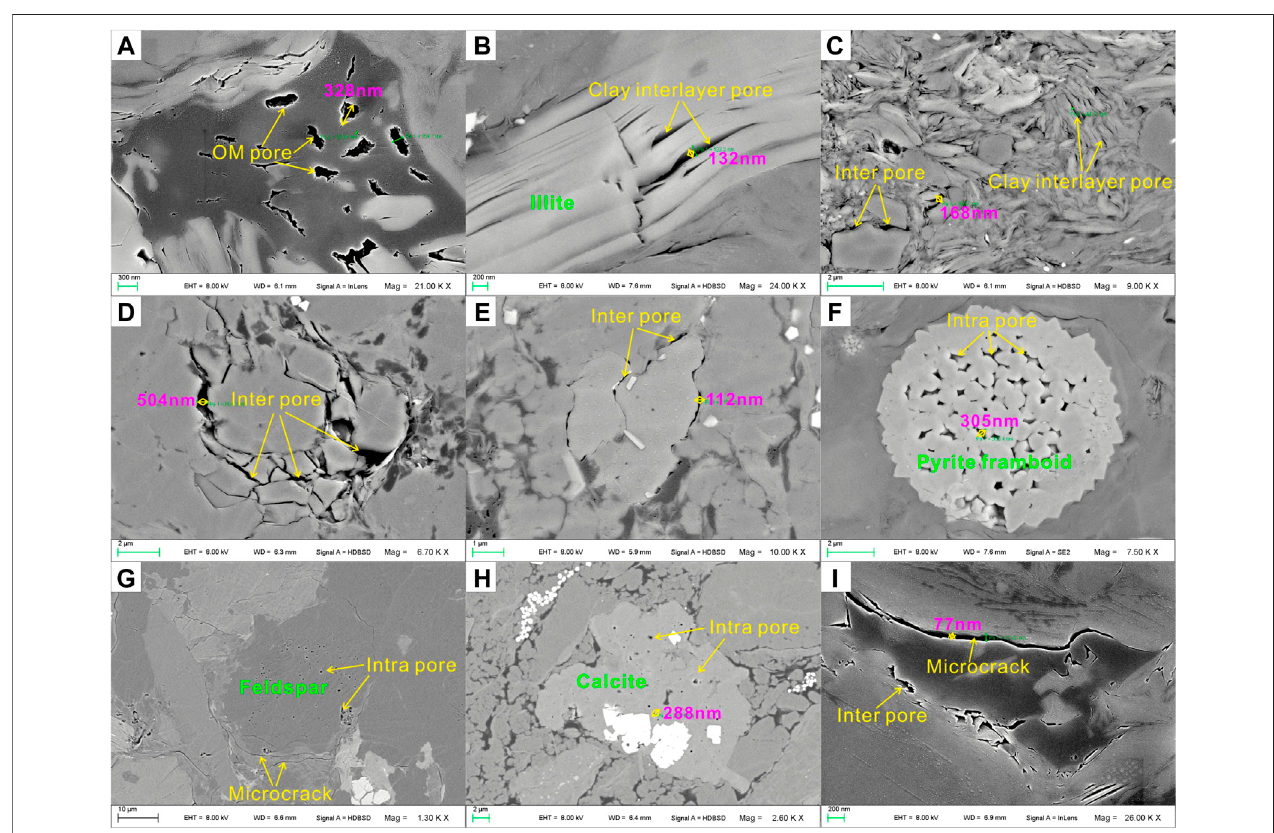
FIGURE 3 | Different types of pores within the Longmaxi Formation shale. (A) Organic matter-hosted pores (OMP); (B) clay (illite) interlayer pores (CIP); (C) numerousinterlayerporeswithinclayminerals; (D) interparticleporesaroundtherimofquartzgrains; (E) interparticleporeswithaslitshape; (F) intraparticleporeswithin pyriteframboids; (G) intraparticle (dissolution)poreswithinfeldspargrains; (H) intraparticle (dissolution)poreswithincalcitegrains; (I) microcrackattheboundaryofOM.